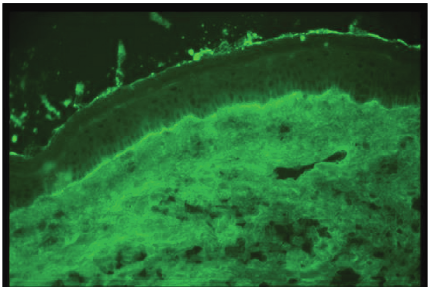
Figure 2: Direct immunofluorescence (DIF) analysis of skin biopsy from the patient no.4 showed a linear staining pattern with immunoglobulin G/complement C3 along the dermoepidermal junction.